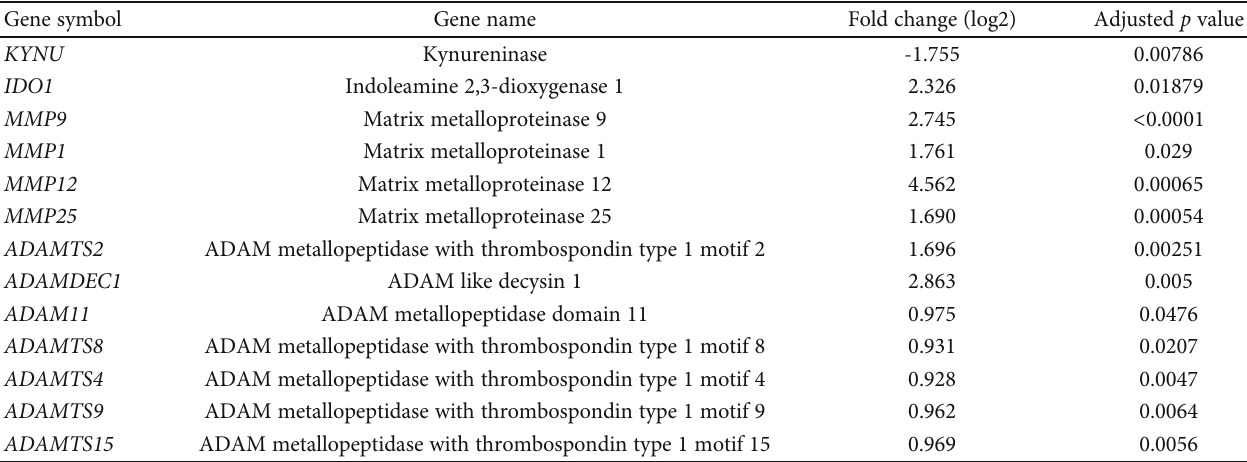
Figure 6: Distribution of immune cells across the samples in training cohort, strati fi ed by assignment to high- (red) and low-risk (gray) groups. Additionally, histogram displaying the distribution of estimated immune cell abundance is plotted on the left (log-transformed), deviation of prognostic score ’ s value from the median on the bottom, and occurrence of the event (black) on the top. Table 2: Selected di ff erentially expressed genes (DEGs) between high- and low-risk groups in the training cohort. The genes were selected based on the biological